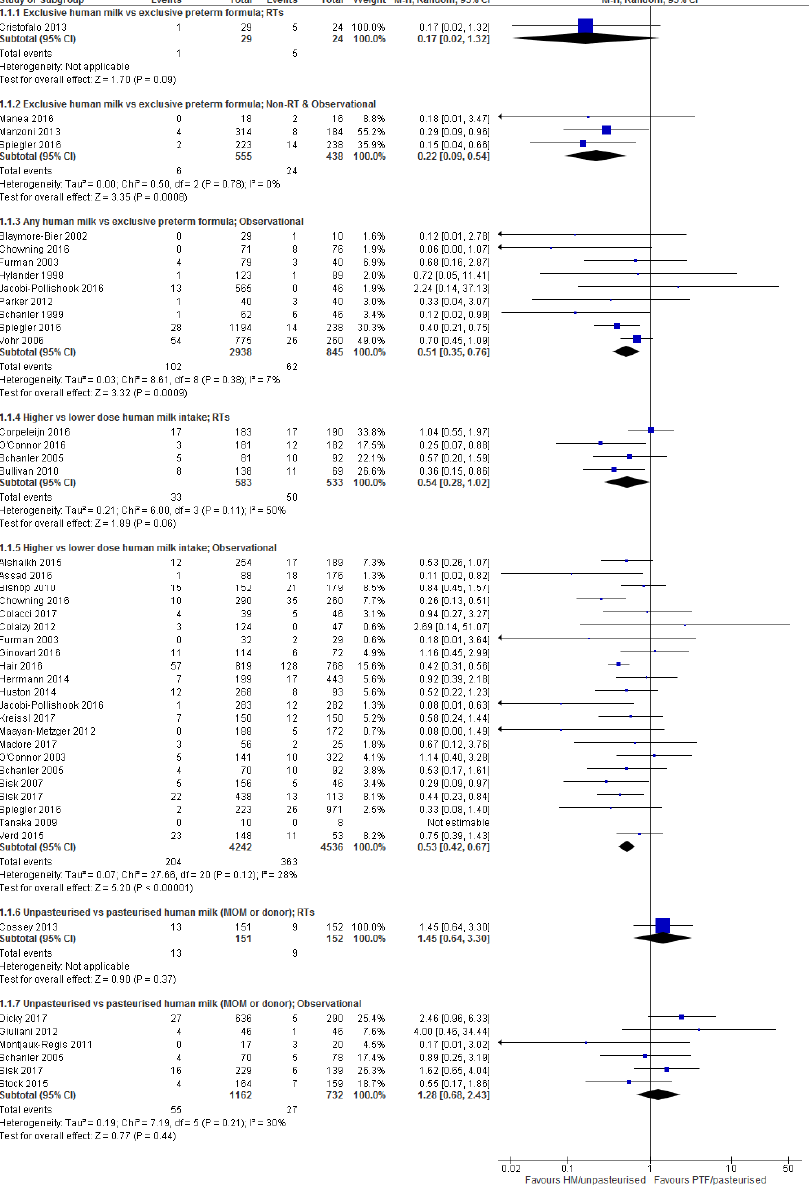
Figure 1. Forest plot of relative risk for the association between human milk and necrotising enterocolitis.